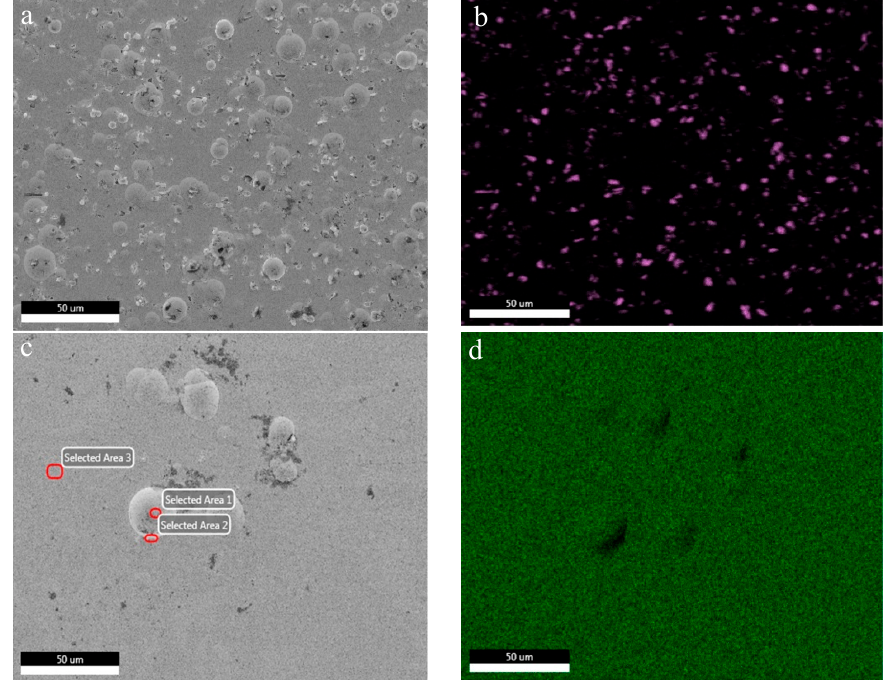
Figure 3. ( a ) SEM and ( b ) EDS map of Si for NiP/10SiC coating deposited from bath 2 at 1 A/dm 2 ; ( c ) SEM image and ( d ) EDS map of P of NiP/20SiC deposited from bath 3 at i : 1 A/dm 2 .